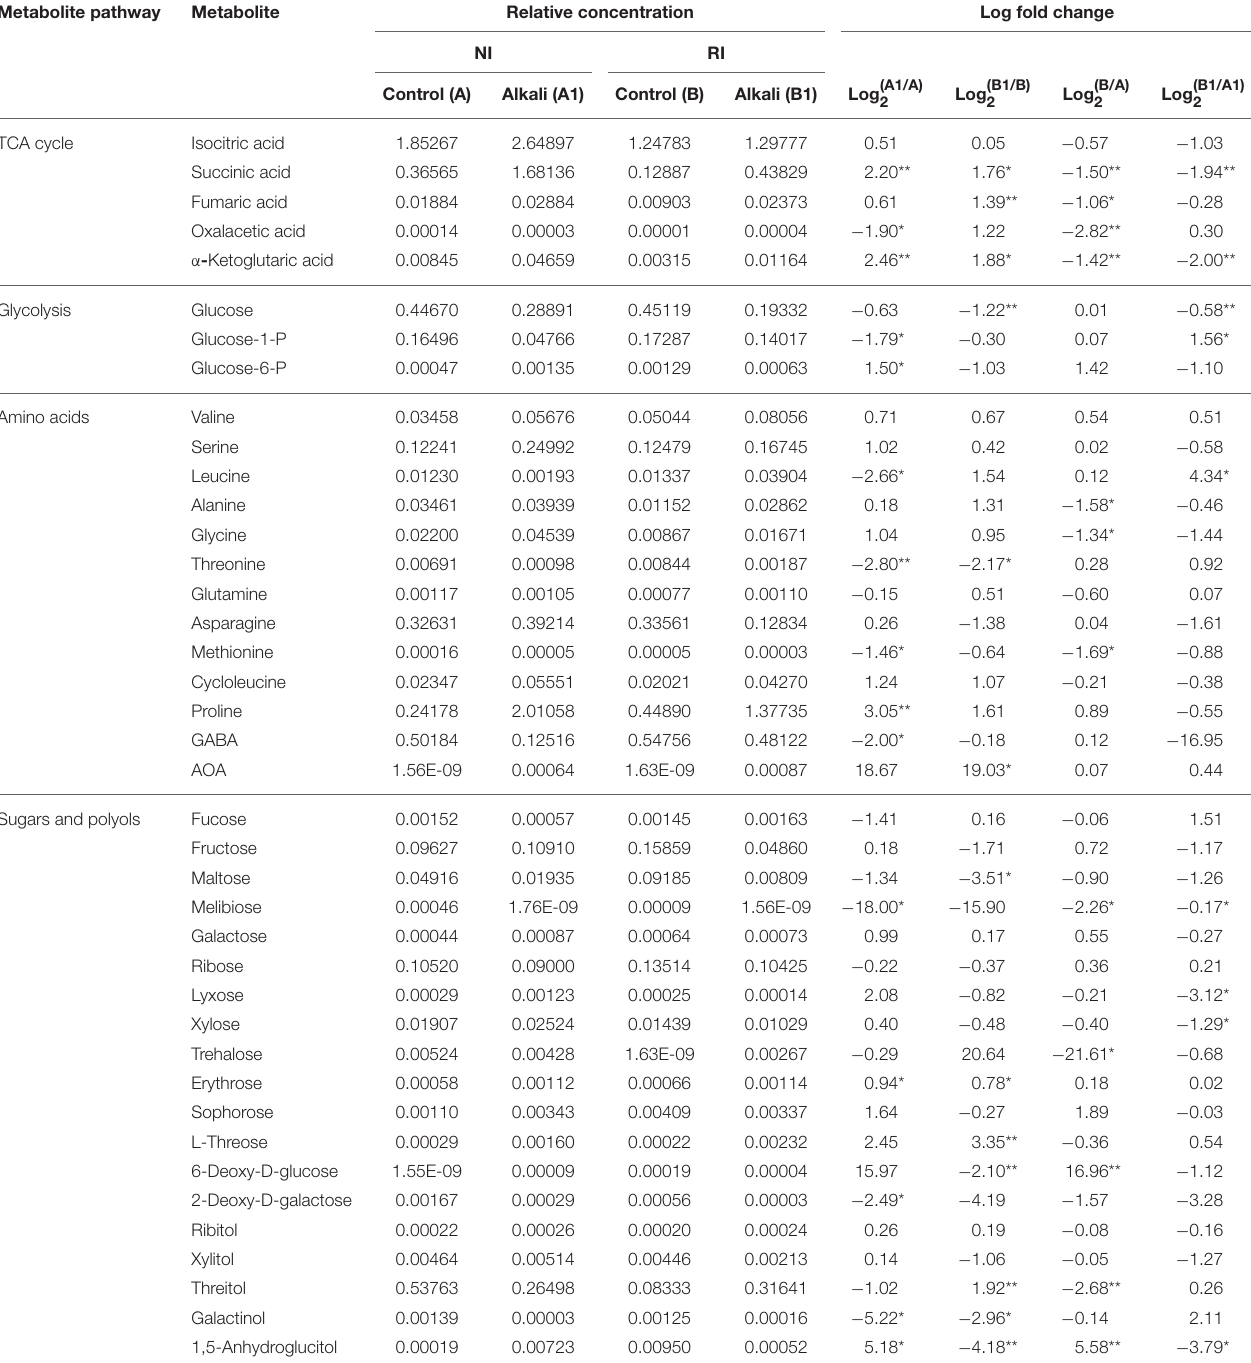
TABLE 1 | Relative concentration and fold changes of major metabolites in roots of NI and RI after 6 d of alkali treatment. Metabolite